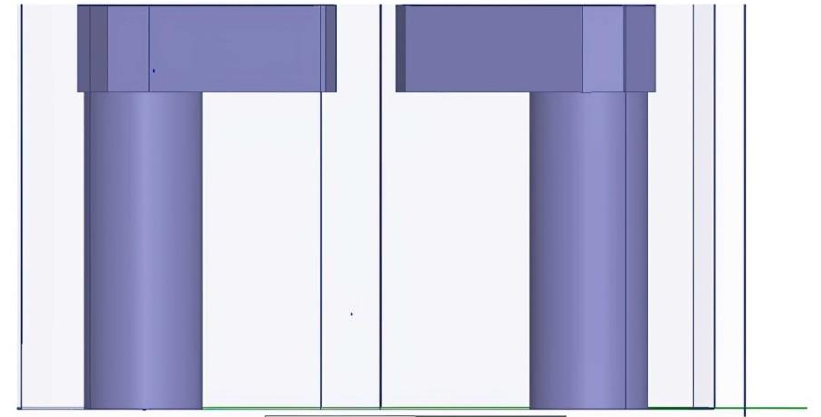
Figure 3. Projected quad-mode resonator with proposed dimensions (side view).